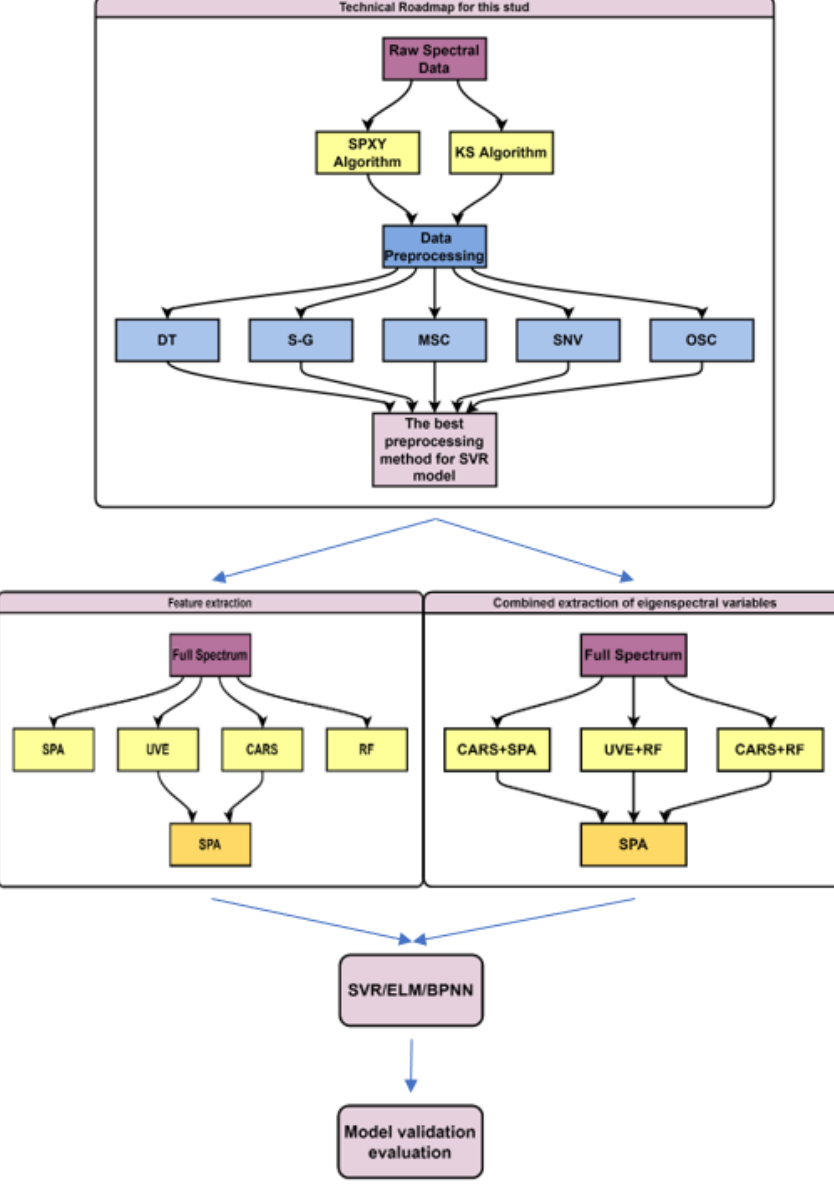
Figure 3. Algorithm flowchart of this study.